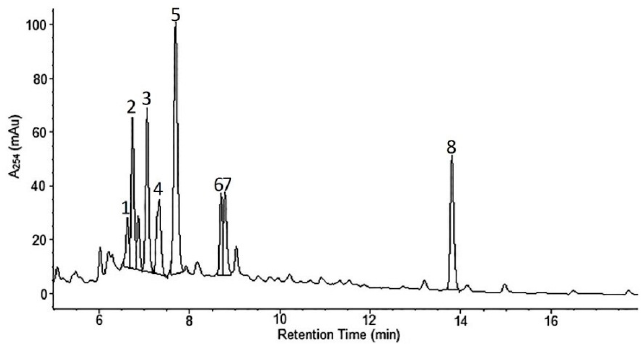
Figure 1. The selected segment of HPLC-DAD chromatogram of the water extract (WE) recorded at 254 nm. Peak assignments (tentative identification): 1. isoschaftoside; 2. schaftoside; 3. vicenin-2; 4. vicenin-3; 5. caffeic acid; 6. isoorientin; 7. isovitexin; 8. leucodin.